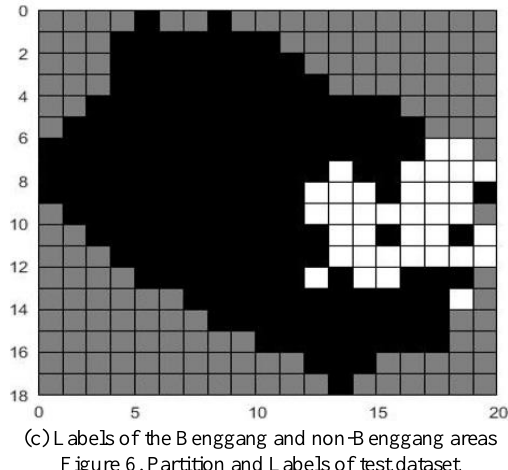
(c) Labels of the Benggang and non-Benggang areas Figure 6. Partition and Labels of test dataset After removing subimages with excessive edge deformation and abnormal elevation changes in each Benggang area, the training and test data and labels are shown in Table 1 below.